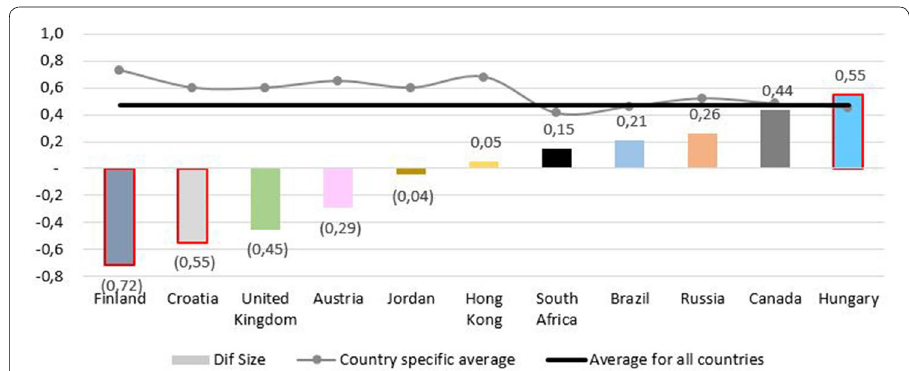
Fig. 7 DIF size: question 5—interest plus capital